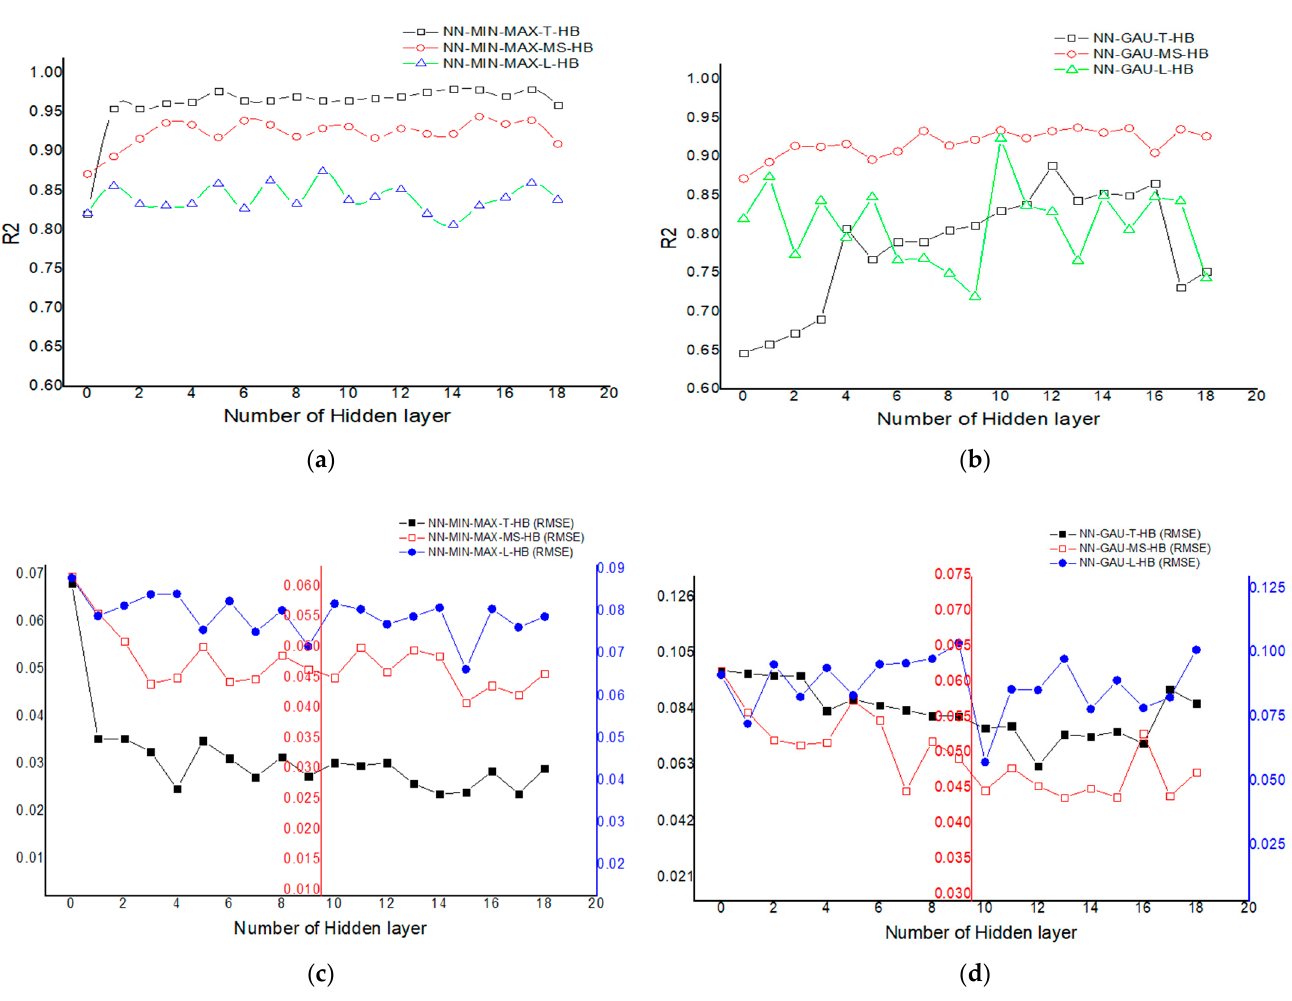
( i ) Figure 6. Scatter plot of predicted versus measured impact energy of a hydraulic breaker as: ( a )